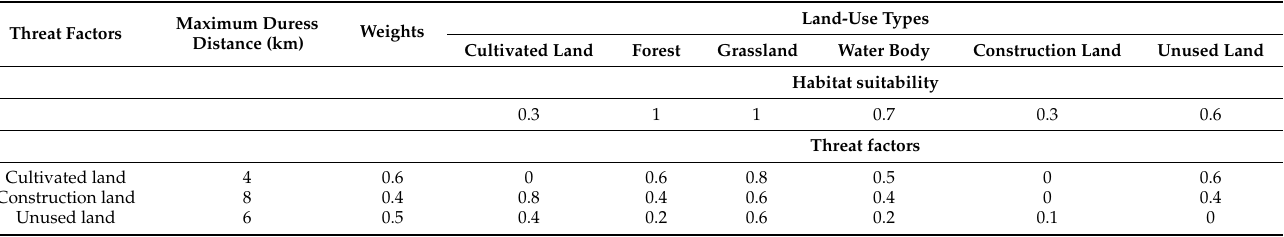
Table 2. Input data used for InVEST